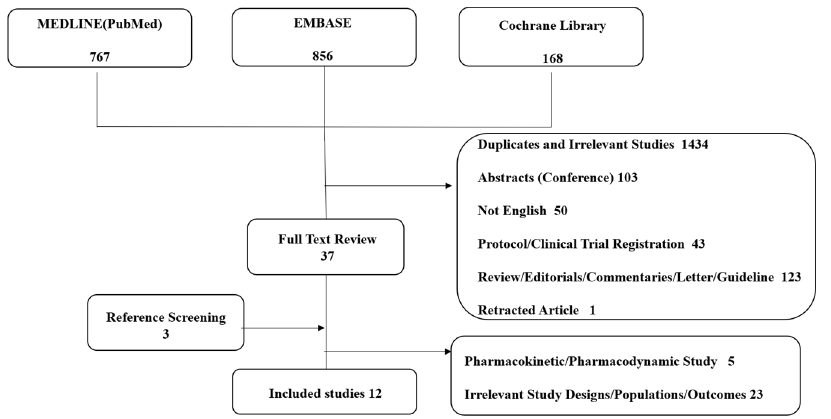
Figure 1. Study selection diagram (Preferred Reporting Items for Systematic Reviews and Meta- analyses (PRISMA)).